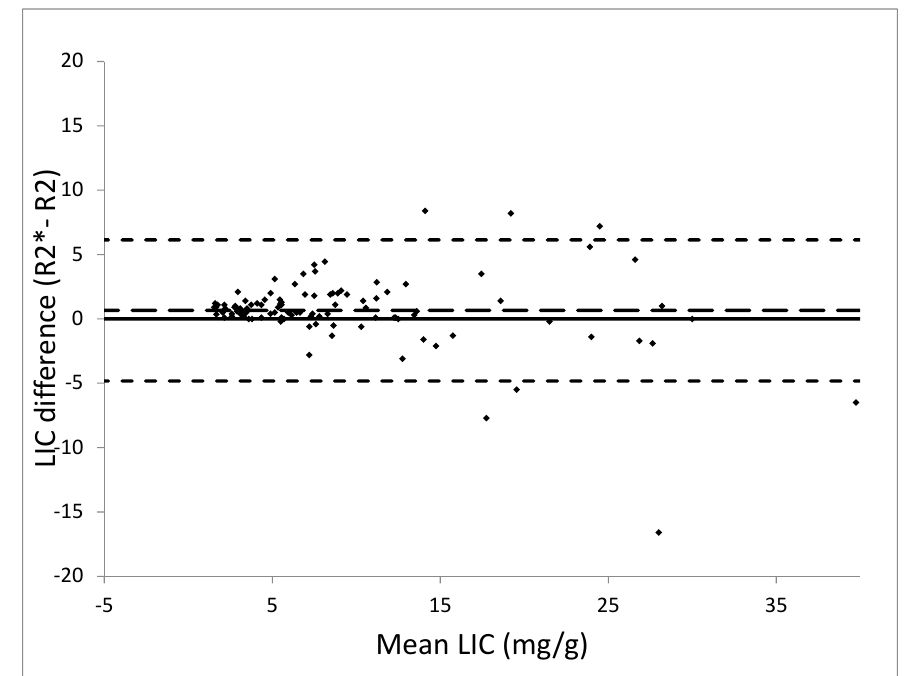
Figure 2. Bland–Altman plot analysis demonstrates strong agreement between LIC R2* and R2 methods. Note scatter increases with increasing LIC. The small-dashed lines indicate the upper and lower 95% limits of agreement between the two measurements. The large-dashed line represents the mean di ff